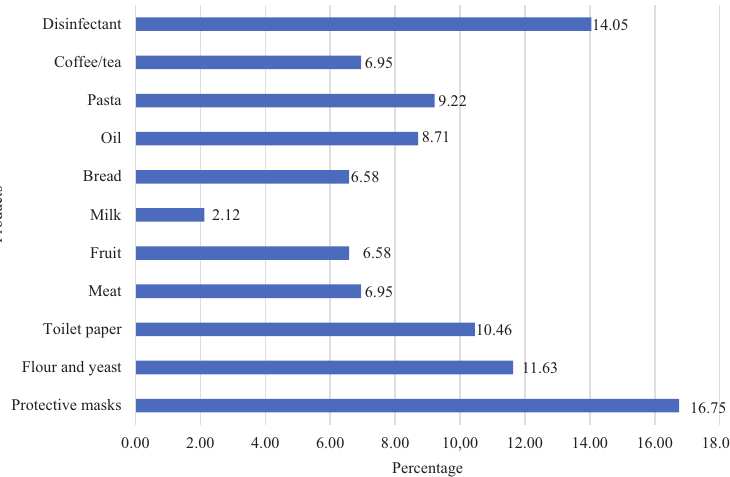
Figure 1. Products that were bought immediately before the lockdown which began on 1.4.2020. (source: prepared by the